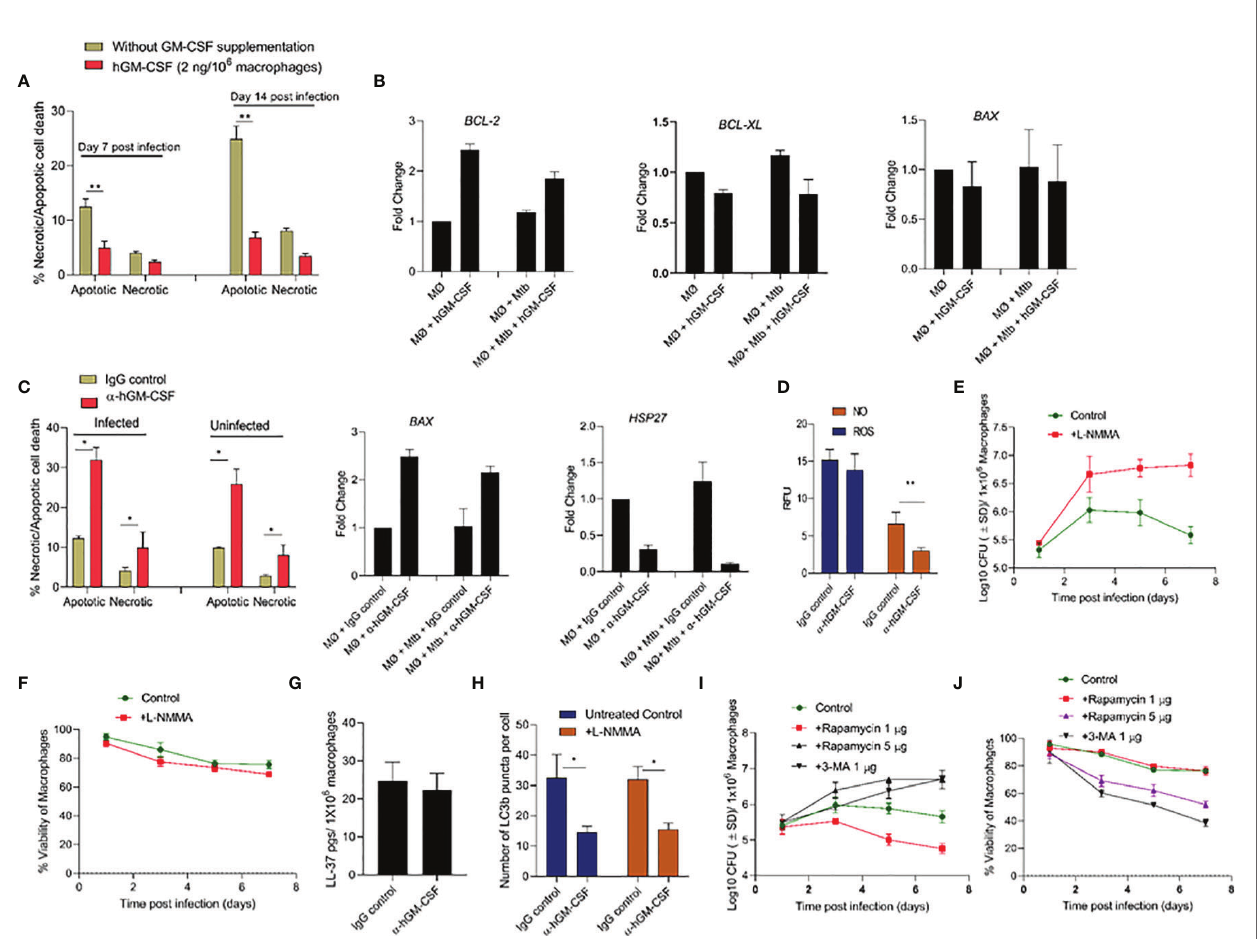
FIGURE 4 | GM-CSF regulates apoptotic/necrotic cell death and bacterial control through autophagy-dependent and independent pathways. (A) Percentage and proportion of apoptotic and necrotic cell death after 7 and 14 days post- M. tuberculosis infection in untreated and hGM-CSF(2 ng/10 6 macrophages)-treated macrophages. At 7 and 14 days post- M. tuberculosis infection, hGM-CSF-treated and untreated macrophages were incubated with Apopxin solution and 7-ADD, and fl uorescence [Ex/Em=490/525 nm (apoptosis, Ex/Em=550/650 nm (necrosis), Ex/Em=405/450 nm (healthy cells)] was measured by fl uorescence microscopy at a magni fi cation of 20X counting 25 fi elds per replicate for each condition. (B) Transcription level expression of cell survival cell death-associated genes BCL-2, BCL- XL , and BAX in hGM-CSF (2 ng/10 6 macrophages)-treated and untreated macrophages with and without M. tuberculosis infection. Gene expression was measured at seven days post-treatment/infection via qPCR assay. (C) Percentage and proportion of apoptotic and necrotic cell death in a -hGM-CSF antibody-treated and IgG isotype-treated macrophages with and without M. tuberculosis infection at day 7. Fluorescent microscopy-based necrosis/apoptosis cell death assay kit was used to determine the percentage of apoptotic and necrotic cell death as described for panel (A) Transcription level expression of cell survival associated genes BAX and HSP27 in a -hGM-CSF antibody (2 m g/10 6 macrophages)-treated and untreated macrophages with and without M. tuberculosis infection was measured at seven days post-treatment/infection via qPCR assay. (D) ROS and NO levels in a -hGM-CSF antibody-treated and untreated (IgG isotype-treated) macrophages at day 7 post- M. tuberculosis infection, as measured through DCFDA and DAF2-DA probes, respectively, using a fl uorimeter. Effect of nitric oxide synthase inhibitor L-NMMA (2 m M/10 6 macrophages) on bacterial burden (E) and host cell viability (F) of M. tuberculosis -infected macrophages over seven days as measured through CFU and alamarBlue assays, respectively. (G) Intracellular levels of antimicrobial peptide LL-37 in a -hGM-CSF -treated and untreated macrophages as measured via ELISA at seven days post-infection. (H) Levels of LC3B puncta in a -hGM-CSF antibody-treated and untreated macrophages in the presence and absence of L-NMMA (2 m M/ 10 6 macrophages) treatment at 7 days post- M. tuberculosis infection. LC3B positive puncta were detected through LC3B antibody staining using a fl uorescent microscope. Effect of autophagy inducer (rapamycin) and autophagy inhibitor (3-MA) on bacterial burden (I) and host cell viability (J) of M. tuberculosis -infected macrophages over seven days as measured by CFU and alamarBlue assays, respectively. Treatment with hGM-CSF or a -hGM-CSF antibody/IgG isotype was performed every seven days beginning from the day of infection. Mtb, M. tuberculosis ; pgs, picograms. Data represent average of three independent experiments carried out in duplicate. Bars and error bars represent means and SD, respectively. *p ≤ 0.05, **p ≤